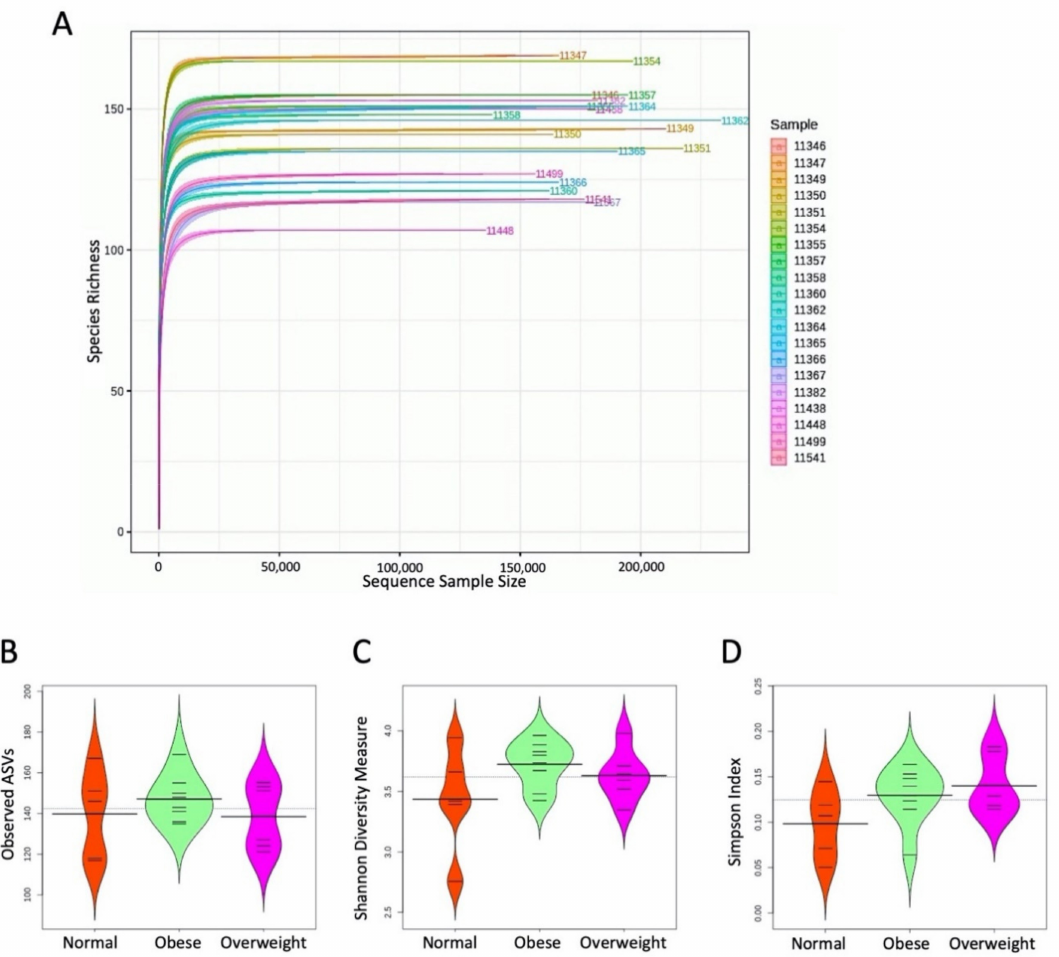
Figure 1. Alpha diversity. ( A ) Rarefaction curve plot showing the sufficient sequencing depth of the samples qualified for diversity analyses; ( B ) distribution of the observed amplicon sequence variants (ASVs); ( C ) Shannon diversity measure; ( D ) Simpson index in each